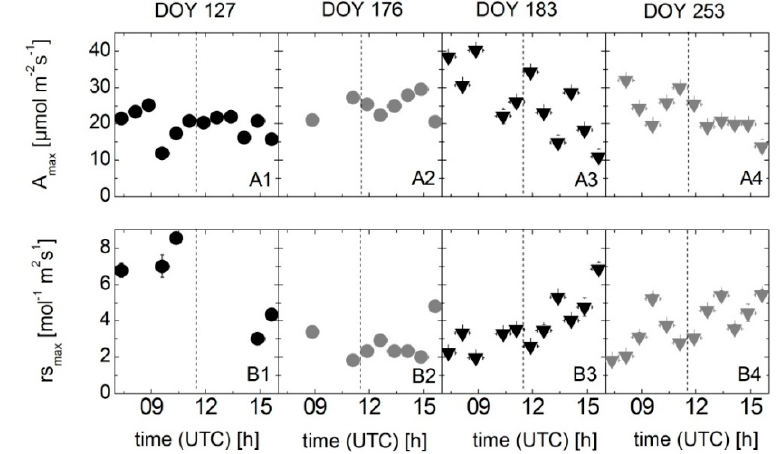
Figure 5. Diurnal behavior of gas exchange parameters derived at saturating light intensities, measured at leaf level for winter wheat (DOY 127, 176) and sugar beet (DOY 183, 253). Circles represent values for winter wheat and triangles values for sugar beet. Top row ( A1 – A4 ): Maximum net photosynthetic CO 2 uptake rate ( A max ); Bottom row ( B1 – B4 ): Maximum stomatal resistance ( rs max ). Vertical error bars indicate uncertainties of the fitting used to determine A max and rs max . Horizontal error bars indicate the time intervals of measurements. Vertical dashed lines indicate solar noon. See also Figure S2 in supplementary materials for additional measurements at three other days that show a similar diurnal behavior of A max .